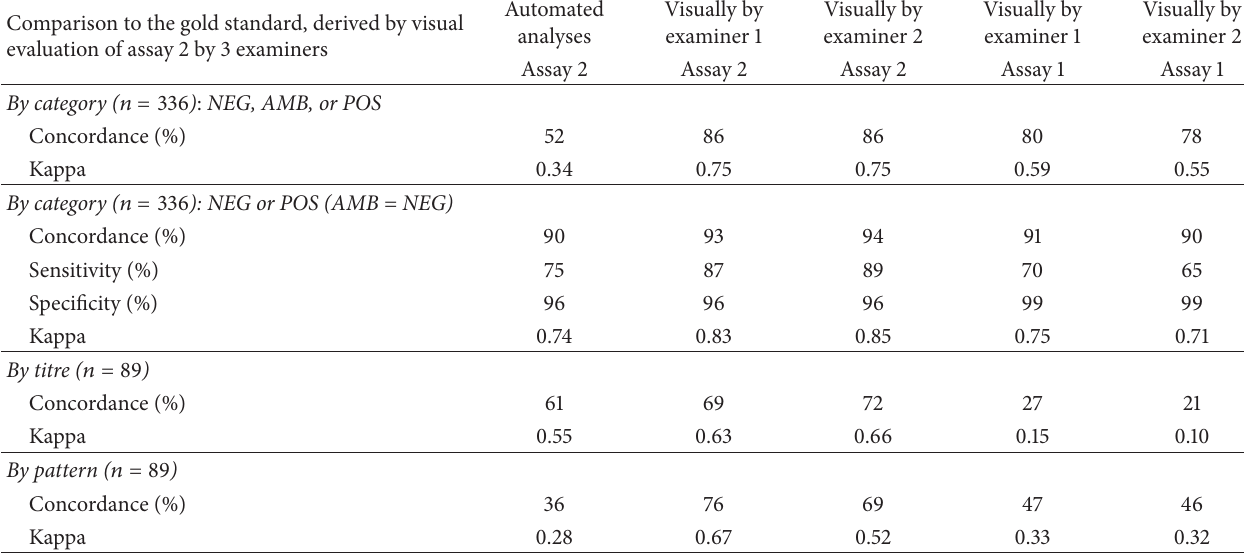
Table 4: Diagnostic performance of automated indirect immunofluorescence ANA detection in comparison to visually obtained results by 2 individual examiners utilizing 2 different assays. Crosstabulation of the diagnostic performance of the automated versus visual analyses by individual examiners of antinuclear antibodies (ANA) by indirect immunofluorescence (IIF) for all 336 serum samples and the subset of 89 that revealed a positive result by visual interpretation of the ANA-IIF-assay 2 (NEG: negative; AMB: ambiguous; POS: